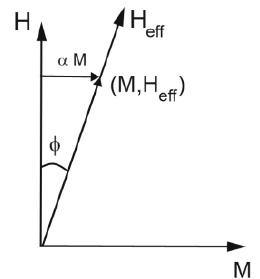
Figure 10. The coordinate systems H = H ( M ) and H eff = H eff ( M ) . The inverse transformation is given as